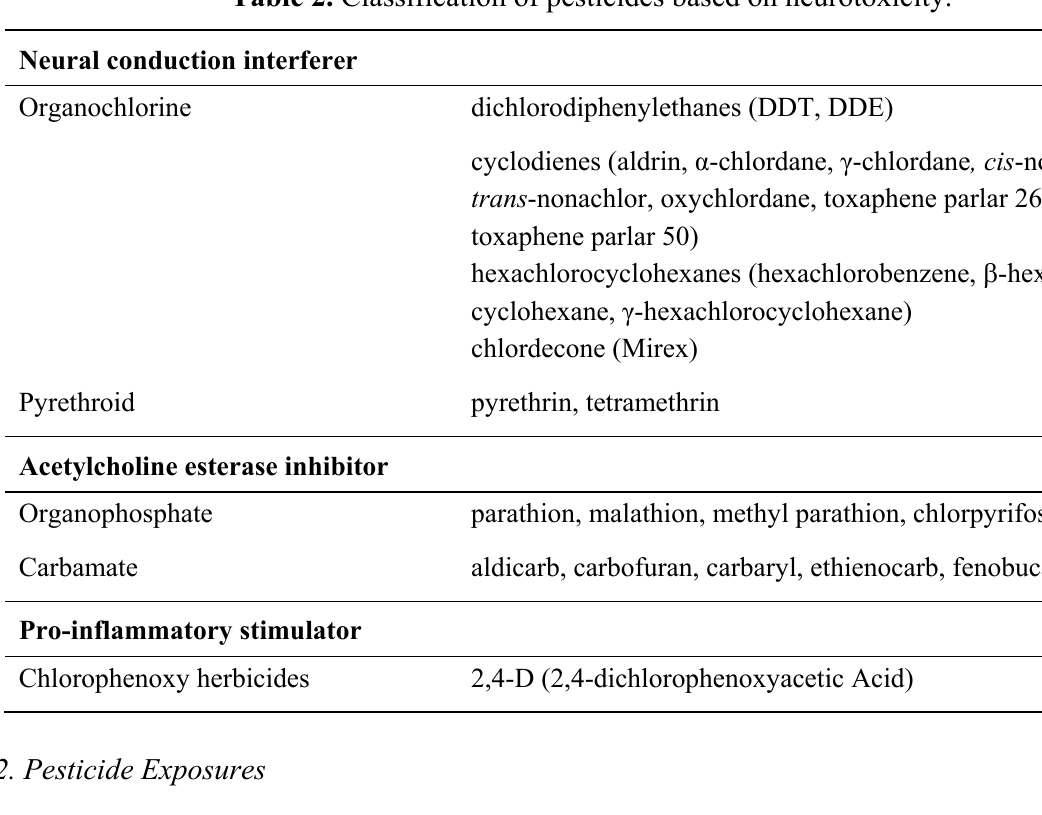
Table 2. Classification of pesticides based on